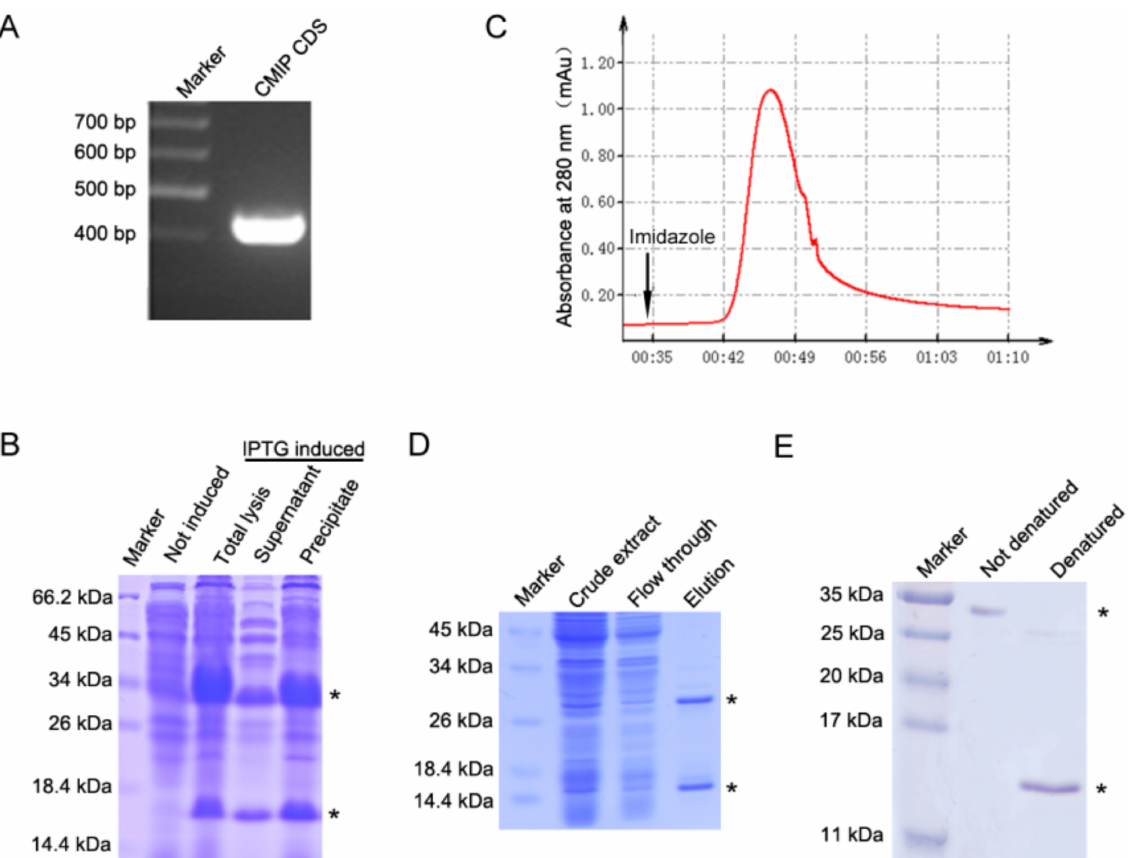
Figure 1. Cloning, expression and purification of rCMIP. ( A ) Total RNA was isolated from the fruiting body of C. militaris and amplified by reverse transcript PCR. The CMIP encoding sequence (414 bp) was amplified with designed primer and detected by agarose gel. ( B ) The rCMIP coding sequence was cloned into pET-30a plasmid, and then transformed into E. coli BL21 cells. Two bands appeared at ~30 kDa and ~15 kDa (marked with asterisks) after 0.5 mM IPTG induction for 16 h. ( C ) rCMIP was eluted as a single peak with elution buffer under 280 nm UV detection. ( D ) The elution of rCMIP produced two bands, corresponding to ~30 kDa and ~15 kDa (marked with asterisks) in molecular mass on SDS–PAGE. ( E ) rCMIP was detected by SDS–PAGE under completely denatured and non-denatured conditions of electrophoresis. A single bond appeared at ~30 kDa and another at ~15 kDa (marked with asterisks) by non-denaturing and denaturing treatment, respectively. The asterisks in ( B , D , E ) indicated the bands of targeted